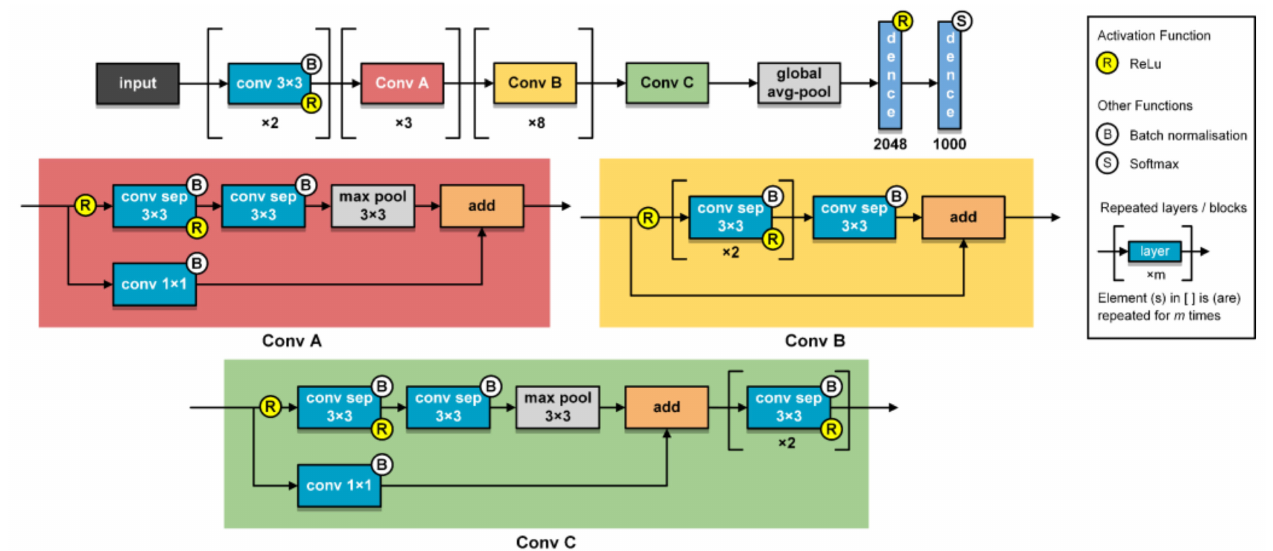
Figure 10. Detailed structure of the Xception feature extractor (adopted in Net-VII, Net-VIII, and Net-IX).